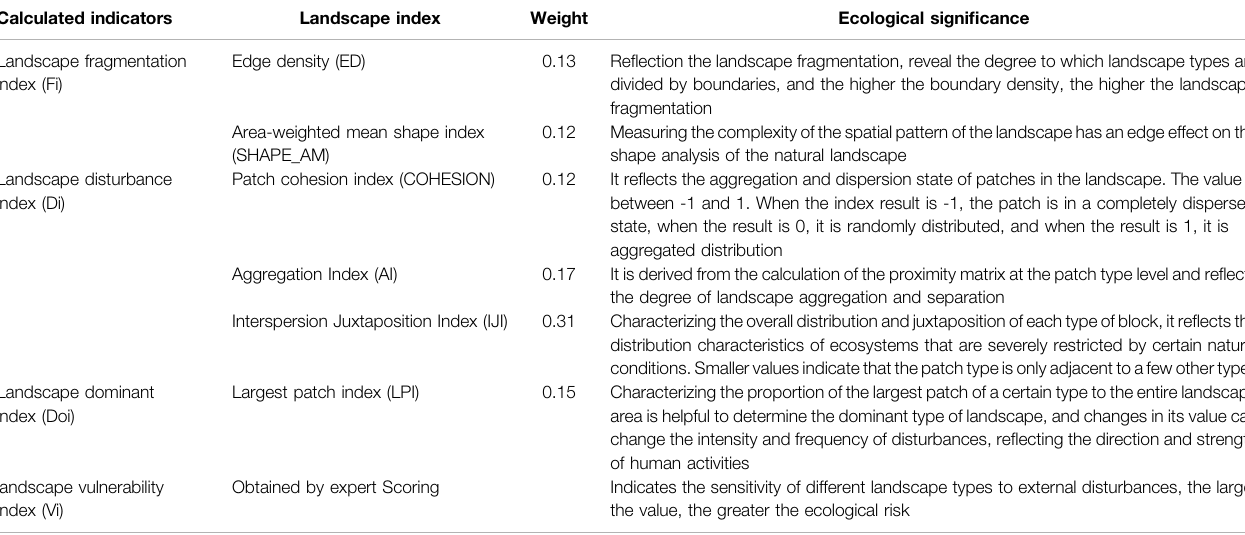
TABLE 3 | Landscape index weights and their ecological signi fi